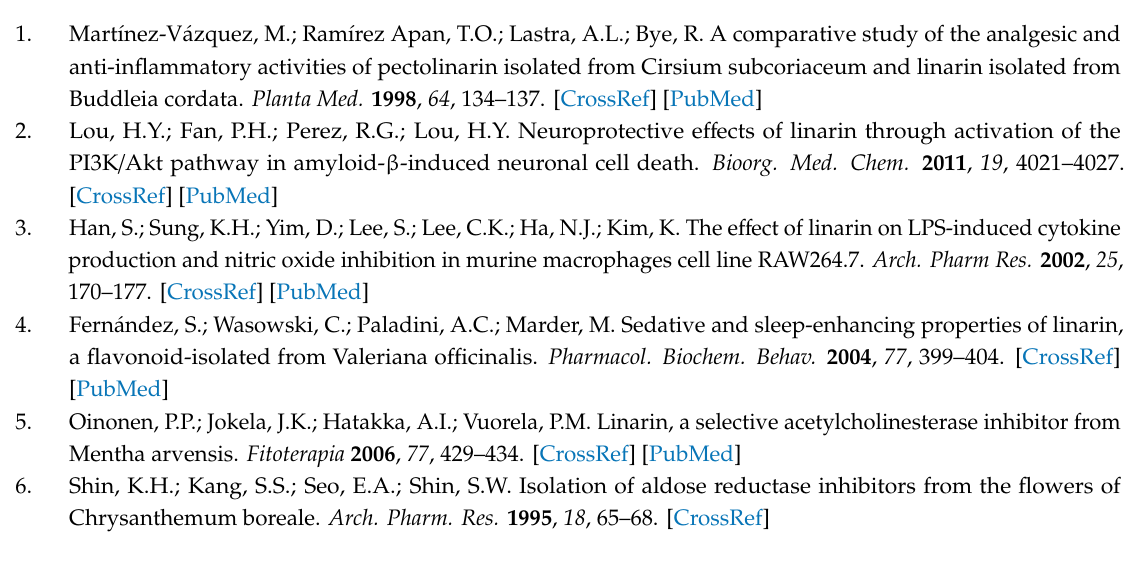
Table S1: Plasma concentrations of apigenin after oral administration of linarin in rats; Table S2: Plasma concentrations of p -hydroxy benzaldehyde after oral administration of linarin in